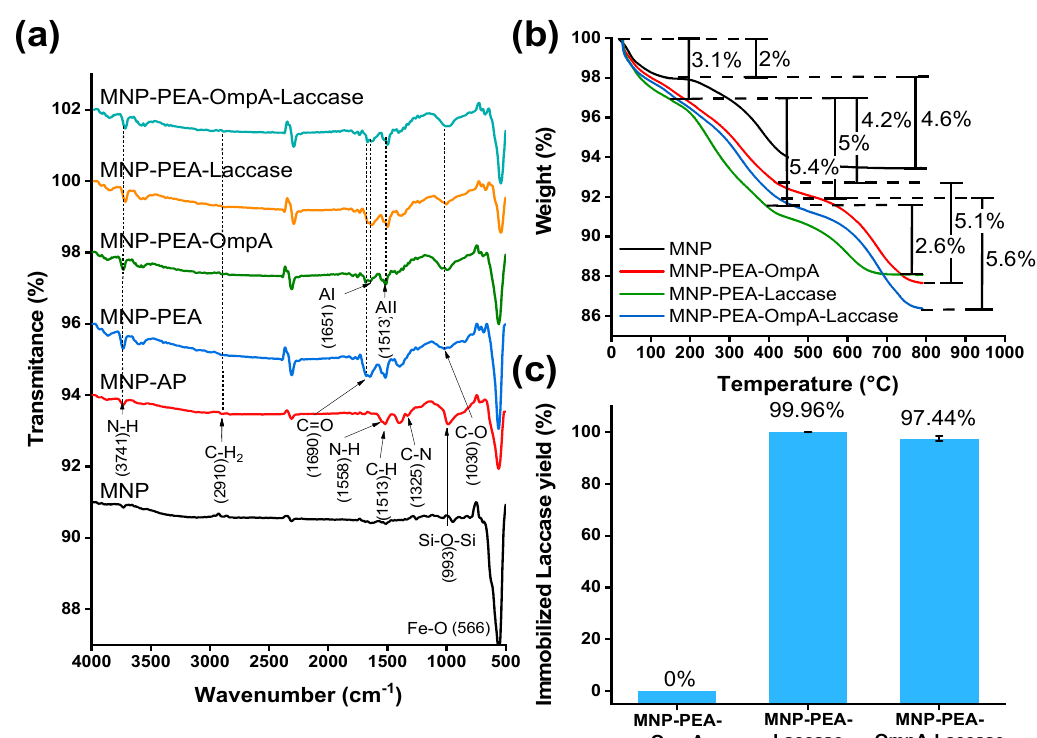
Figure 3. Characterizations of bionanocompounds: ( a ) FTIR spectra of MNP (black), silanized MNP (red), PEA coated MNP (blue), immobilized MNP-PEA-OmpA (green), MNP-Laccase (yellow) and MNP-PEA-OmpA-Laccase (turquoise). ( b ) Thermogravimetric assay (TGA) of MNP (black), MNP-PEA-OmpA (red), MNP-PEA-Laccase (green), and MNP-PEA-OmpA-Laccase (blue). ( c ) Immobilization yield (%) of immobilized Laccase in all samples, as calculated from an enzymatic assay based on the oxidation of ABTS.